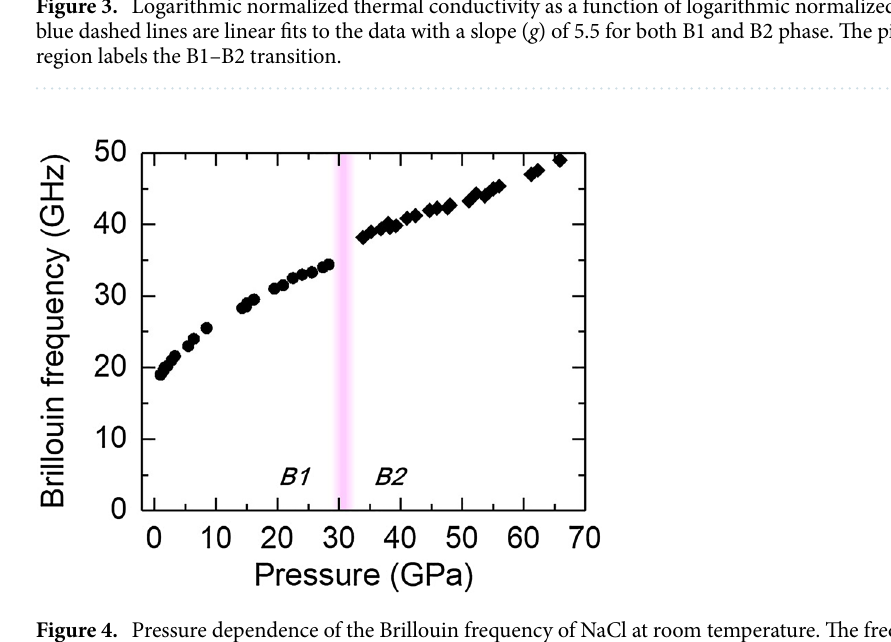
Figure 4. Pressure dependence of the Brillouin frequency of NaCl at room temperature. The frequency increases by about 10% across the B1–B2 transition (pink shaded